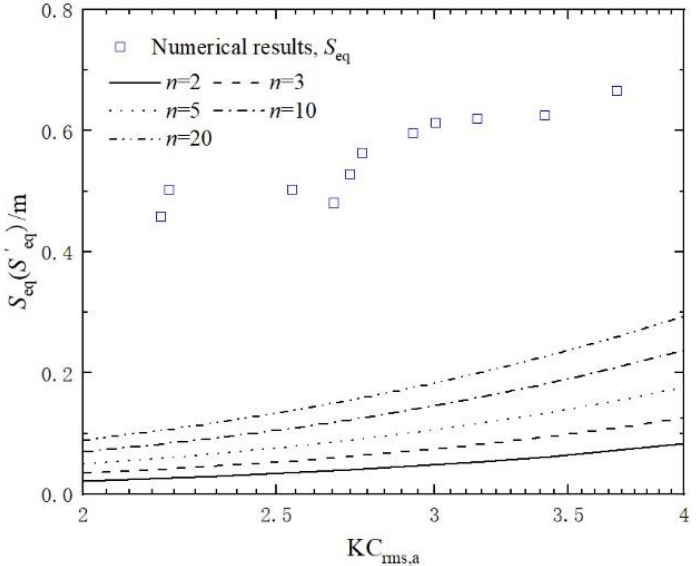
Figure 9. Comparison of S eq between the predicting results from the stochastic model and the nu- merical results of the present